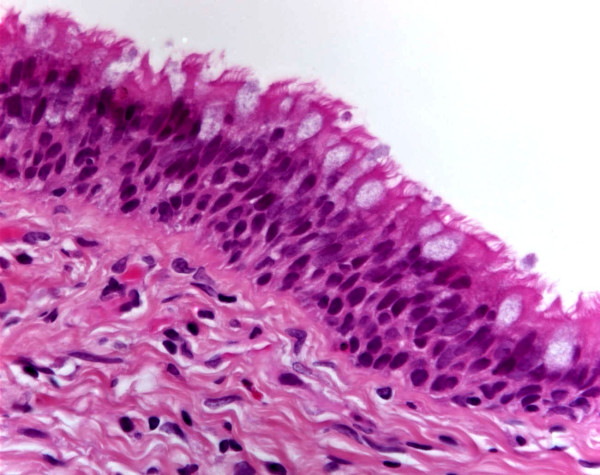
High power image of cyst lining showing ciliated columnar epithelium (hematoxylin-eosin stain × 400).